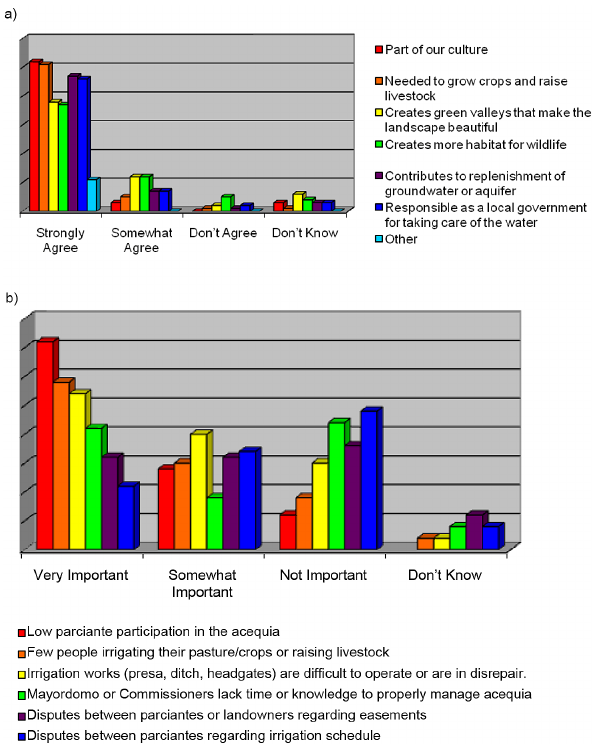
Figure 13. (a) Responses to the question “what is your opinion